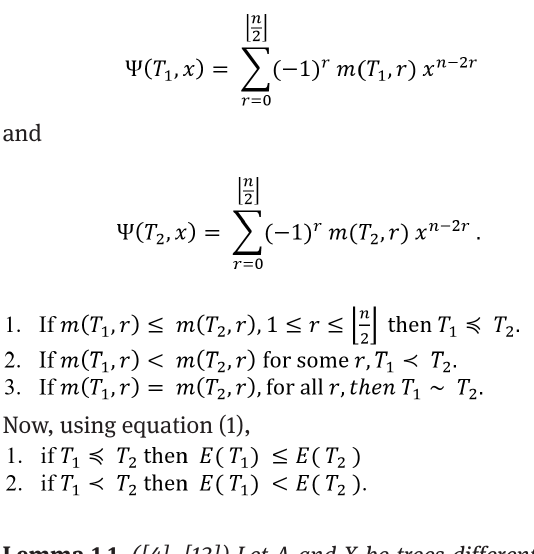
Figure 4: Maximal energy tree in Ω( n